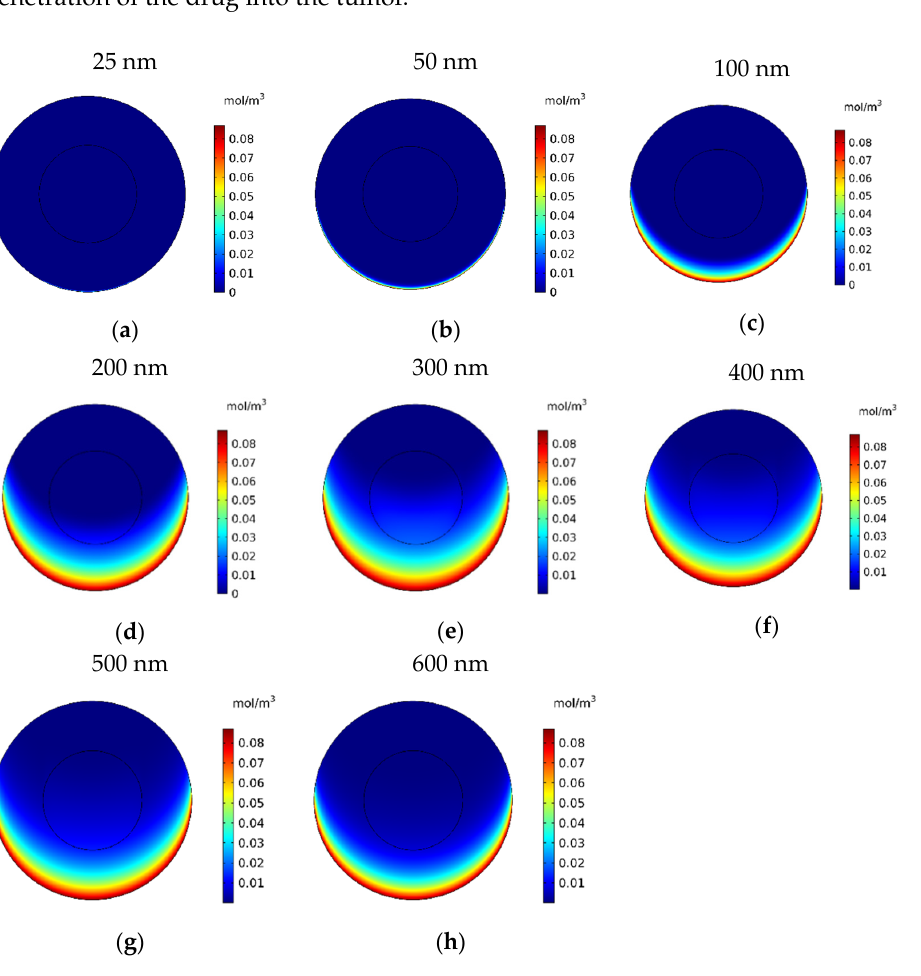
Figure 13. Comparison of the mean concentrations of the free drug (CF) in the tumor over 60 min of treatment using magnetically controlled IP chemotherapy for different nanoparticle sizes. In Figure 14, C F distribution along the vertical line of the tumor is presented. Drug delivery using nanoparticles with a radius of 300 and 400 nm resulted in deeper penetra- tion of the drug into the tumor and, subsequently, it increased C F in the tumor. However, 25 and 50 nm particles showed poor drug penetration into the tumor. Efficacy parameters w 1/2 , PA rel , FK PA , and FK eff are reported in Table 6. There was an increase in w 1/2 values from 0.003 cm for 25 nm particles to 0.235 cm for 300 nm particles. As the nanoparticle size further increased, w 1/2 decreased, until it reached 0.143 for 600 nm particles. The smallest PA rel among the compared nanoparticles was related to 25 nm na- noparticles (0.20%), and 300 nm nanoparticles with 55.02% had the largest PA rel among the studied MNPs. FK eff values for different sizes of MNPs after 60 min of treatment are pre- sented in Figure 15. FK eff was calculated as the lowest value for 25 nm nanoparticles, which was equal to 0.11%, whereas it was the highest for 300 nm particles with 24.1%.